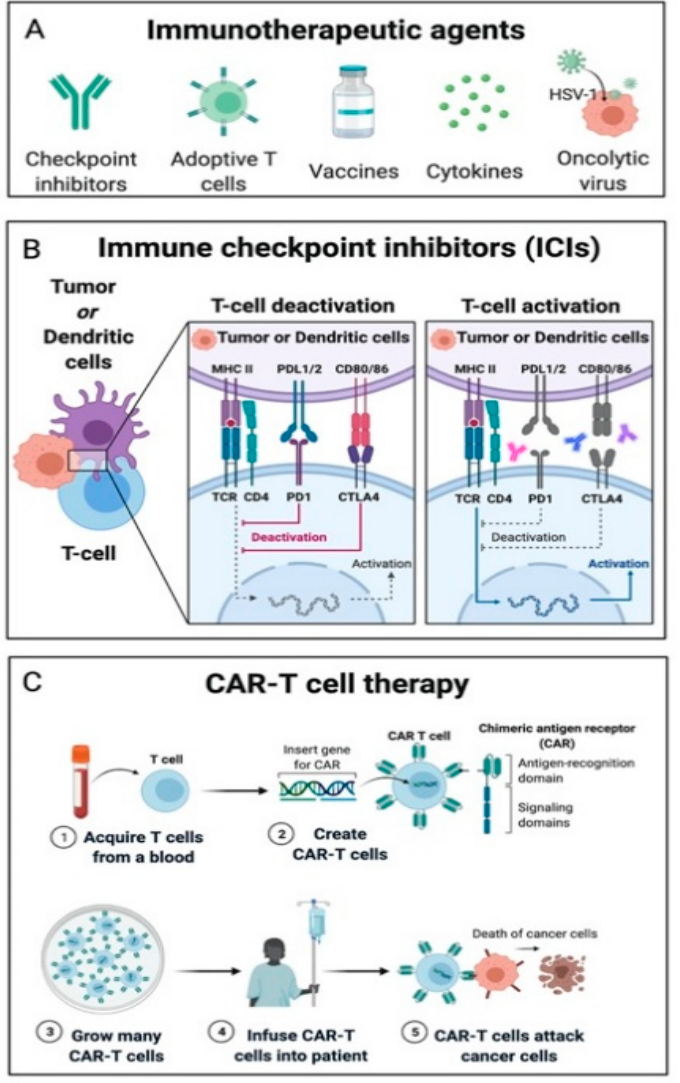
Figure 2. Simplified schematic representation of the new immunotherapy strategies for cancer ( A ), with particular attention to the most widely used immunotherapies: the Immune Checkpoint Inhibitors ( B ) and the CAR-T Cell Therapy ( C ).